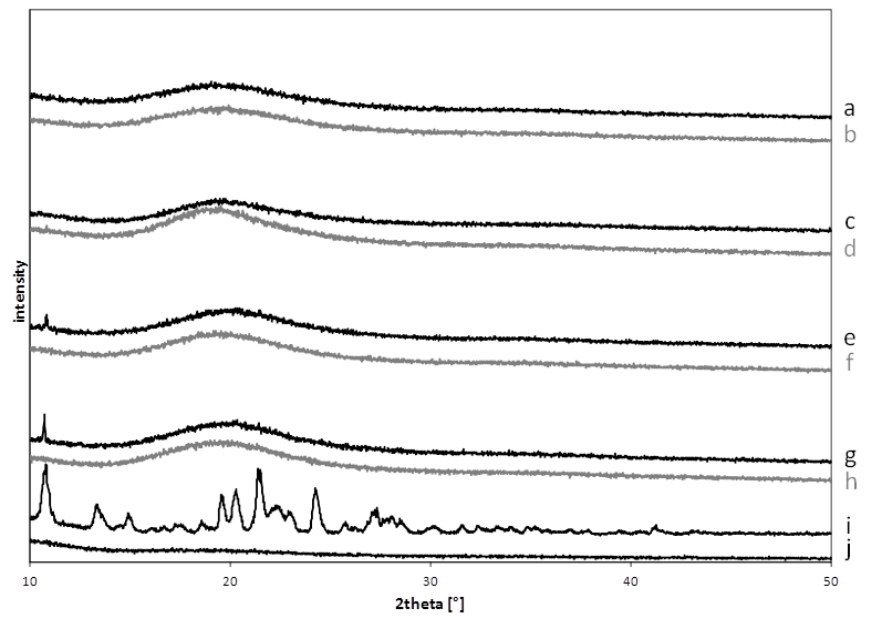
Figure 3. X-ray pattern of dimenhydrinate and drug-free formulations, pure dimenhydrinate and pure film forming polymer. ( a ) DMD; ( b ) PMD; ( c ) DCA; ( d ) PCA; ( e ) DS; ( f ) PS; ( g ) D; ( h ) P; ( i ) dimenhydrinate; ( j ) LycoatRS720 (batch codes according to Table